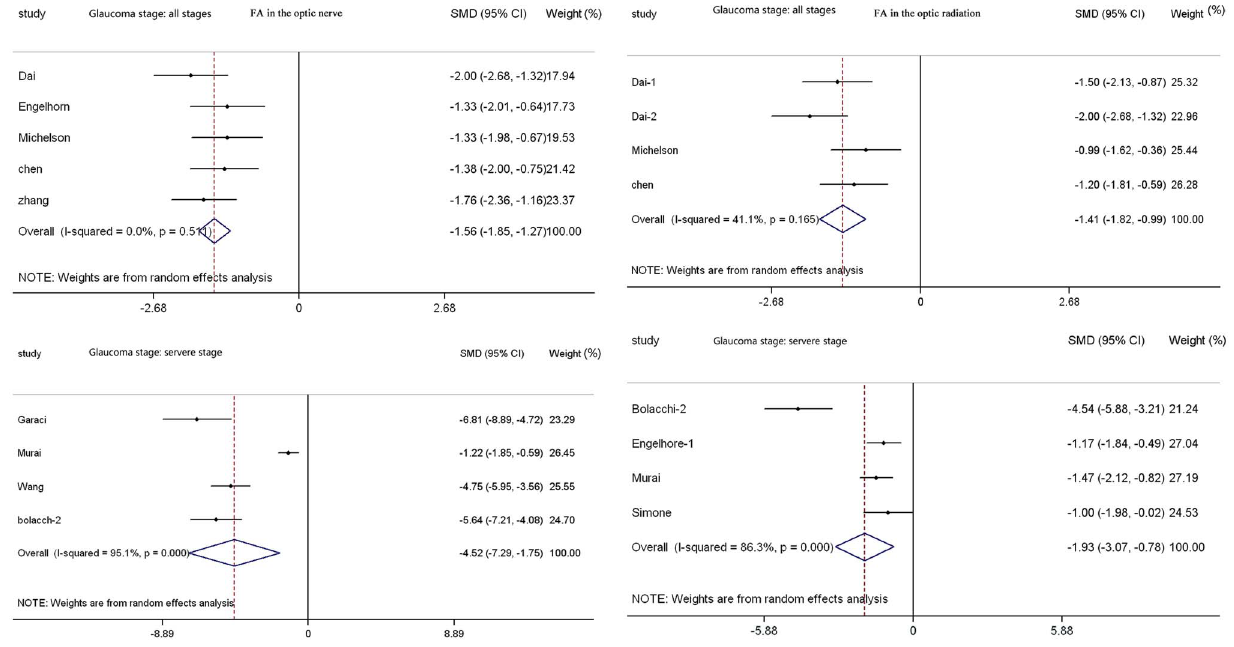
Figure 7. Results of an FA analysis with respect to glaucoma severity in the optic nerve (a) and optic radiation (b) of patients with glaucoma compared with controls. There is an apparent difference between two severity stage groups (a: all stages, b: severe stage). We can conclude that there was decreasing FA of the optic nerve with increasing glaucoma severity (P , 0.05, and the diamond shape appears on the left side). FA: fractional anisotropy; SMD: standardized mean difference; CI: confidence